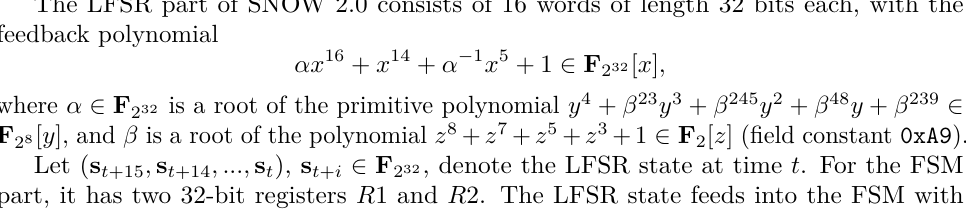
Figure 1: The keystream generation phase of SNOW